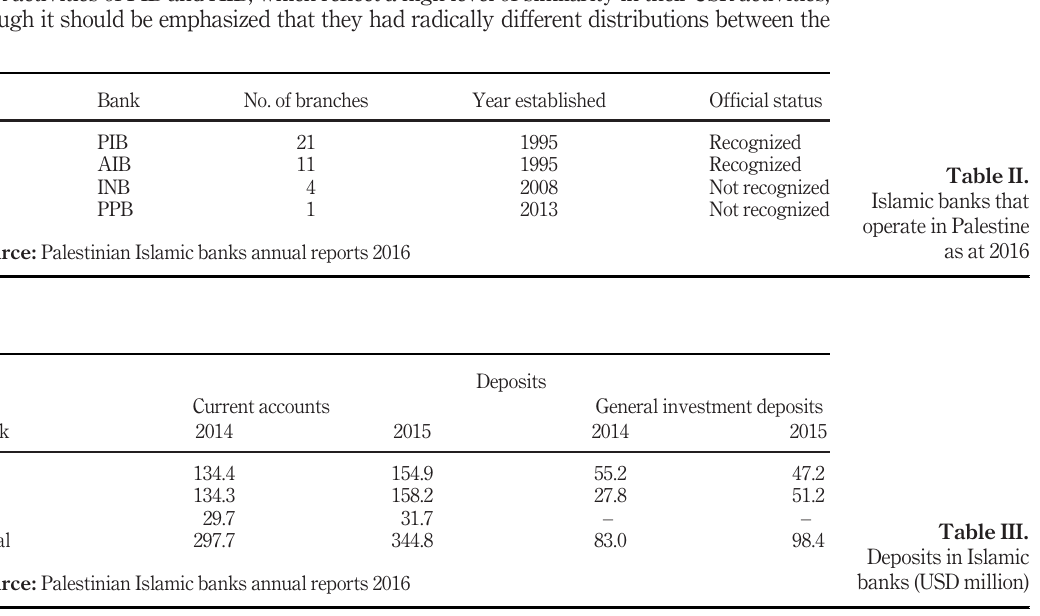
Table III. Deposits in